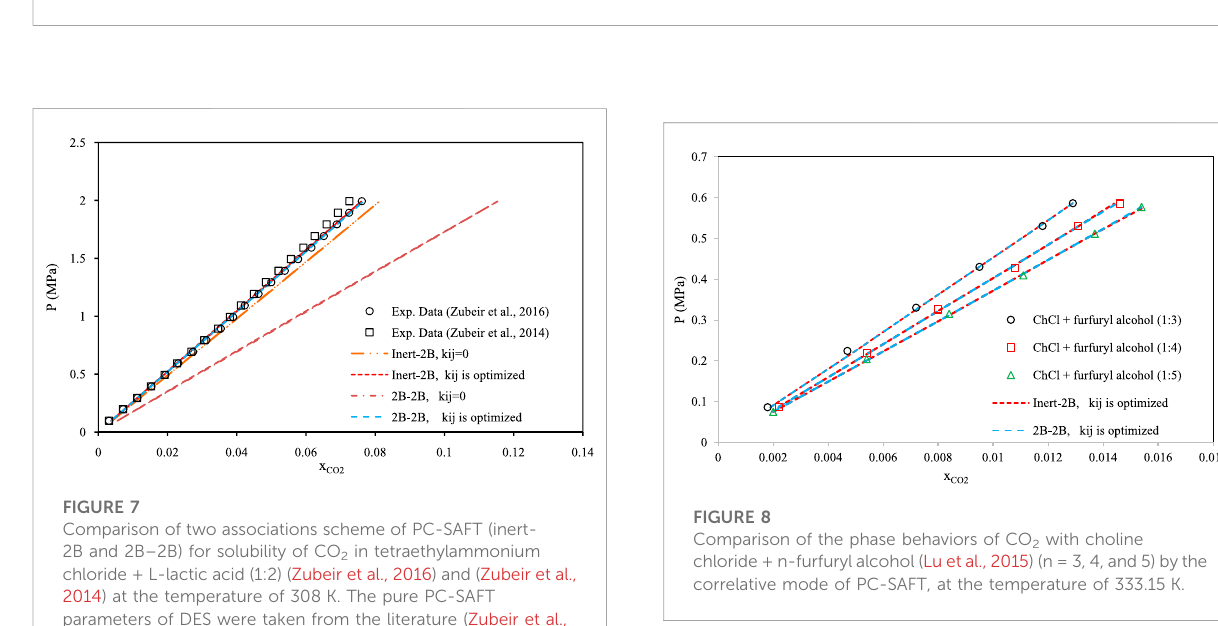
FIGURE 7 Comparison of two associations scheme of PC-SAFT (inert- 2B and 2B – 2B) for solubility of CO 2 in tetraethylammonium chloride + L-lactic acid (1:2) (Zubeir et al., 2016) and (Zubeir et al., 2014) at the temperature of 308 K. The pure PC-SAFT parameters of DES were taken from the literature (Zubeir et al., 2016).